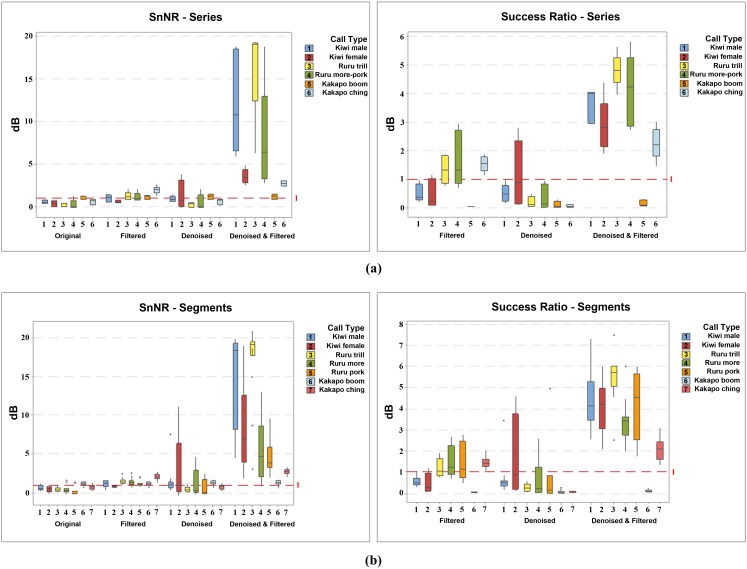
Box plot view of Table 5.(a) call series and (b) segmented calls.